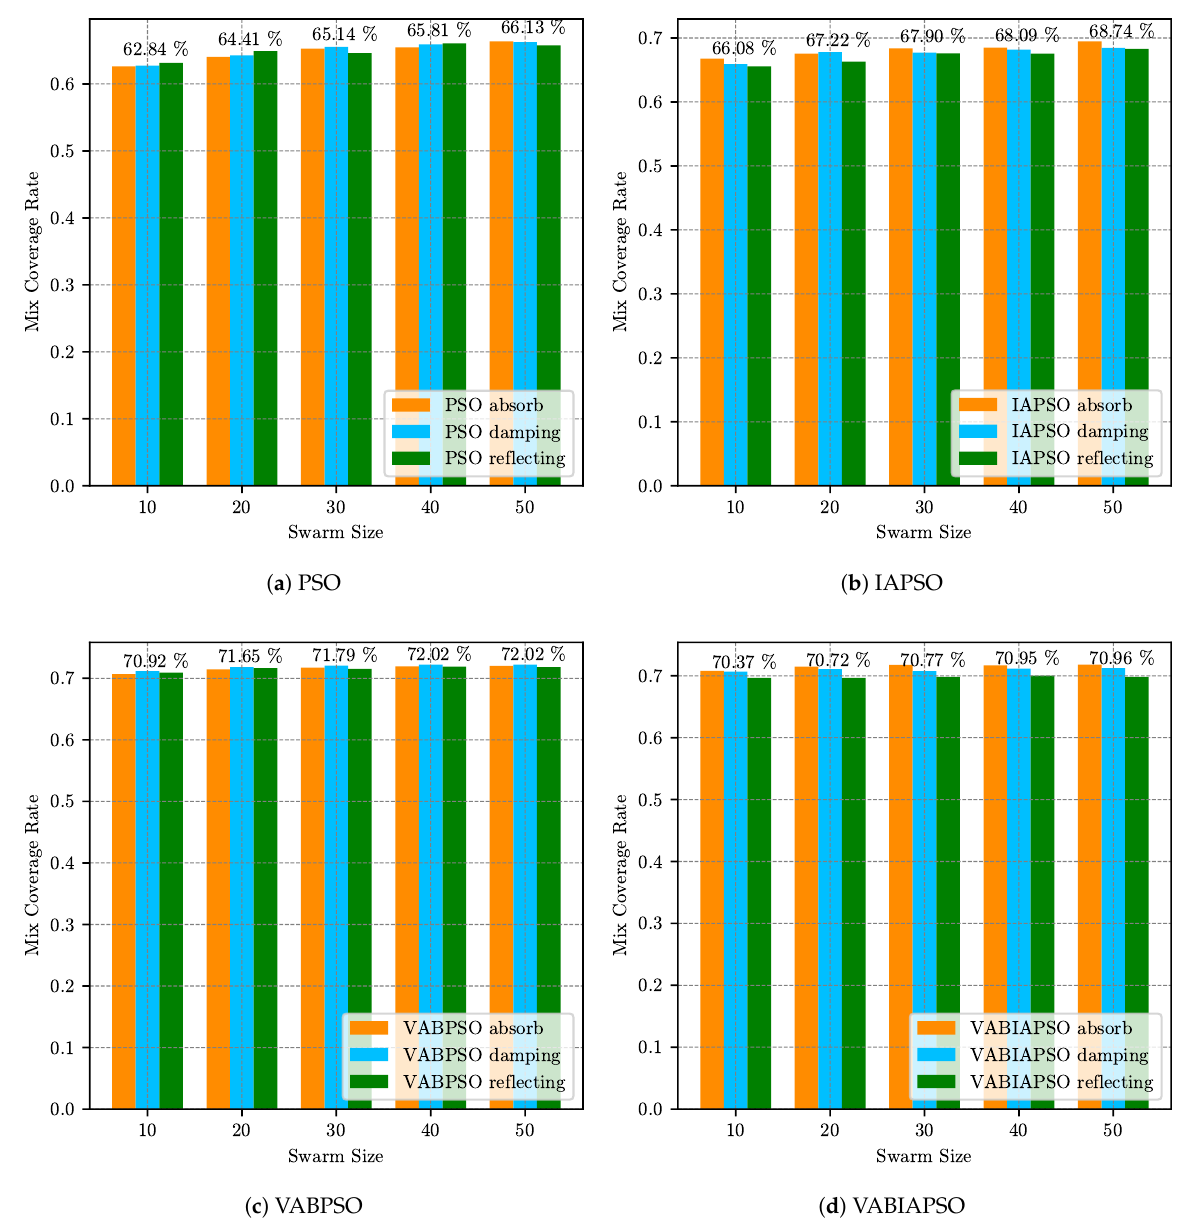
Figure 10. The mix coverage of the four algorithms under different swarm sizes in the real